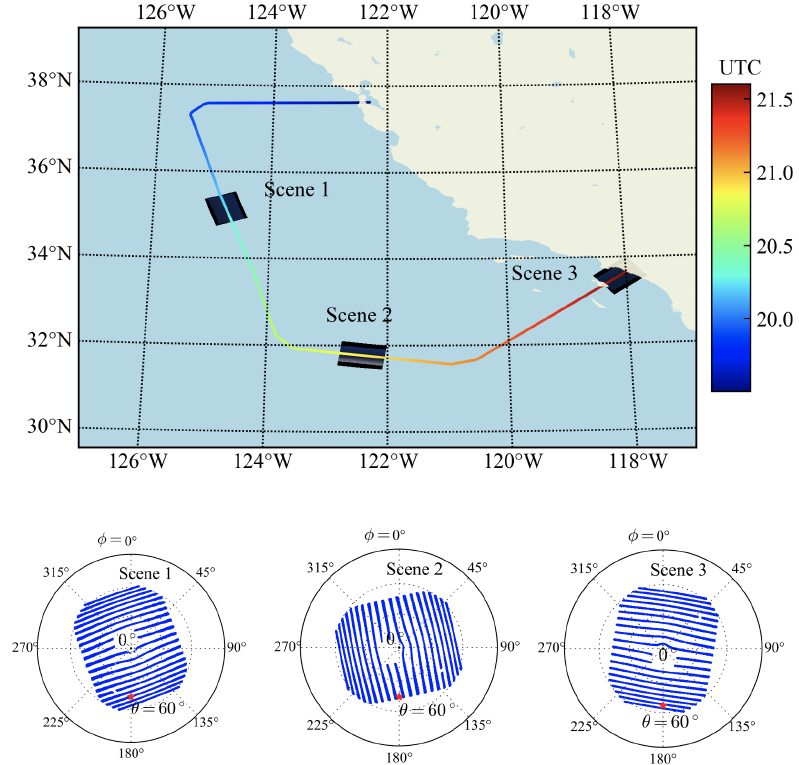
Figure 12. The location of the three ocean scenes from AirHARP from ACEPOL on 23 October 2017. The flight track color shows the UTC time along the flight path. The aircraft flew at an altitude of 20.1km. The viewing zenith and relative azimuth angle (relative to the solar azimuth angle) for the 440nm band from all pixels in the corresponding scene are shown in the bottom polar plots. The central portion of viewing angle plot is removed due to water condensation on the lens. The averaged solar zenith angles for the three scenes are 47.0 ◦ , 45.6 ◦ , and 52.9 ◦ , respectively, as indicated in the polar plots by the red asterisks.